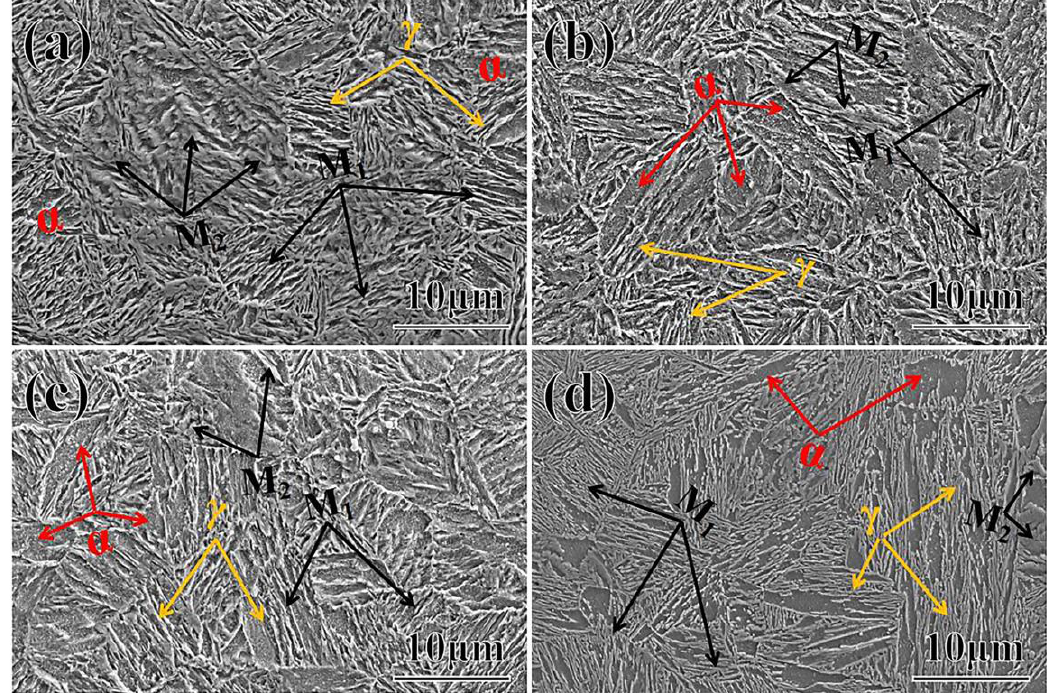
Figure 2. SEM images at different partition temperatures: ( a ) P300; ( b ) P280; ( c ) P260; ( d ) P240.